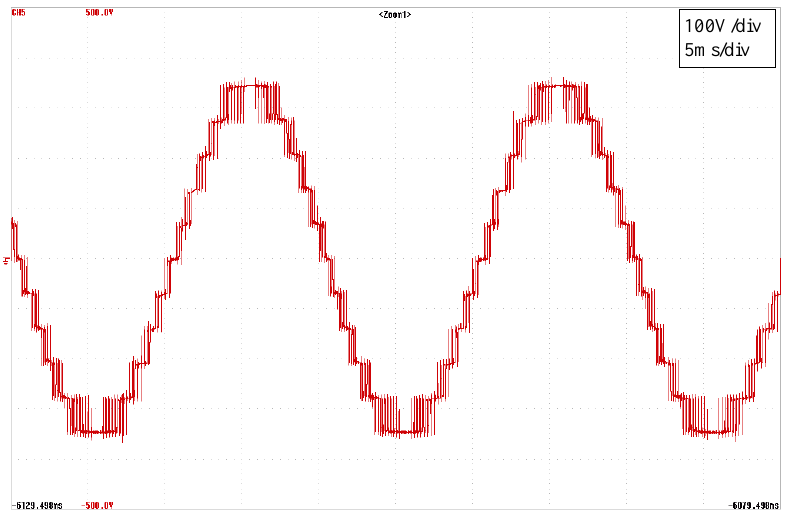
Figure 23. SVM line-to-line output waveform without load.